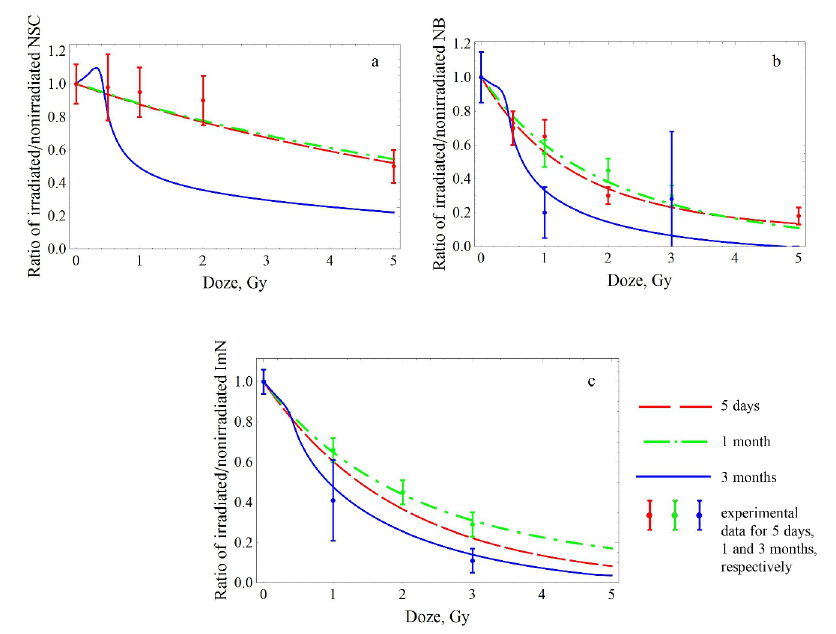
Figure 2. Dose-dependent response of hippocampal neurogenesis to acute exposure of iron radiation in comparison with experimental data [7–9] after 5 days, 1 and 3 month postirradiation: a) neural stem cells, b) neuroblasts, c) immature